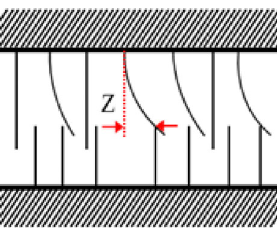
Fig. 16 LuGre model-contact